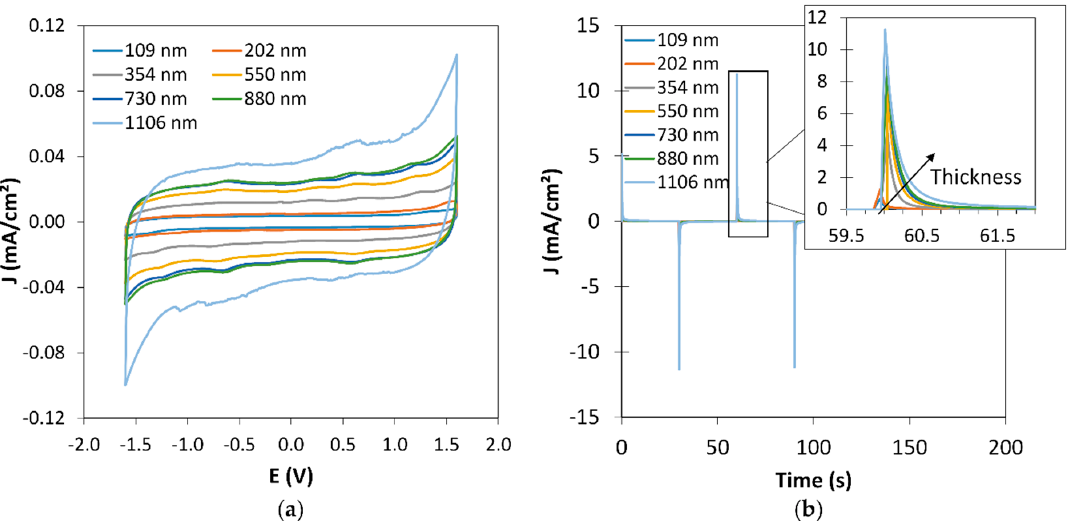
Figure 1. ( a ) Cyclic voltammograms of the electrochromic symmetrical displays built from PEDOT:PSS thin films with varying thickness from 109 nm to 1106 nm, ( b ) chronoamperograms ( CA ) of the electrochromic symmetrical displays built from different PEDOT:PSS thicknesses. Potentials of +1.6 V and − 1.6 V were applied for 30 s alternatively.